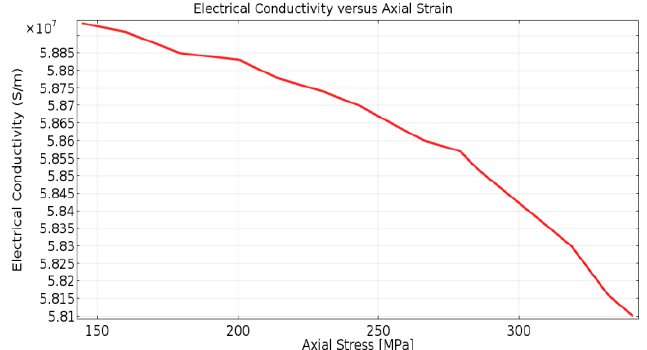
Figure 4. Evolution of electrical conductivity as a function of mechanical stresses experimentally obtained for a copper wire [5].